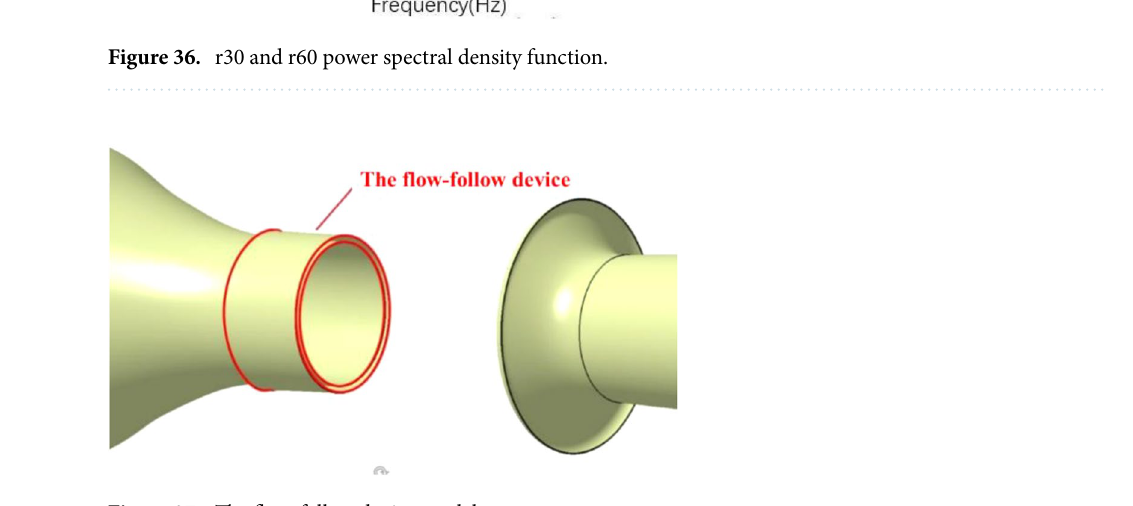
Figure 37. The flow-follow device